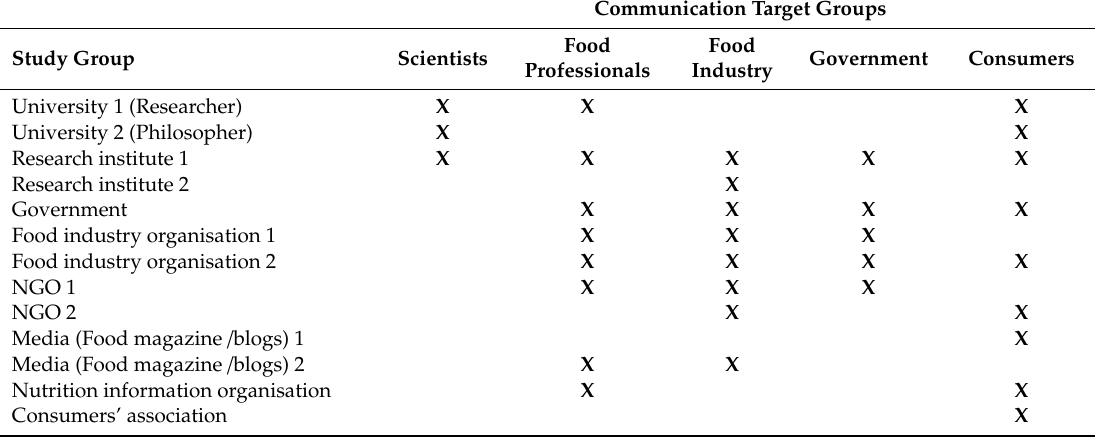
Table 2. Study group food experts in the Netherlands: organisations and main target groups for communication ( n =